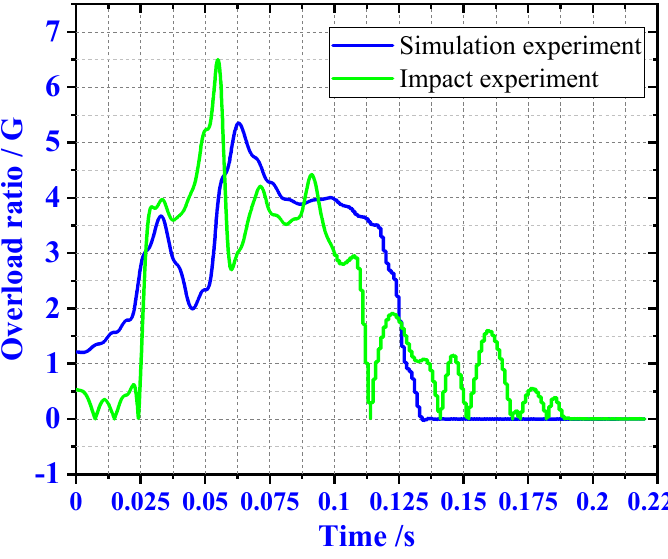
Figure 14. Comparison of experimental results.